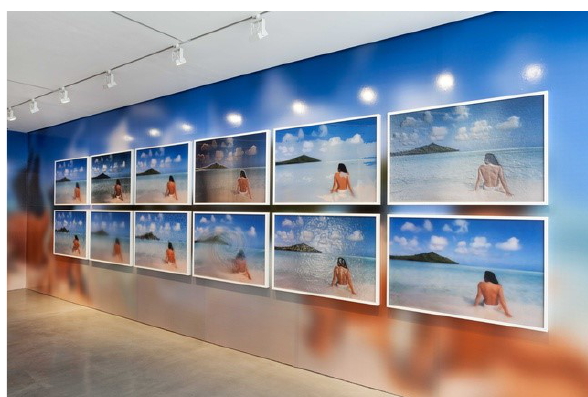
Figure 8 | Constant Dullaart, Jennifer in Paradise (2013-ongoing). View of the exhibition; Stringendo, Vanishing Mediators. Carroll/Fletcher Gallery, London,